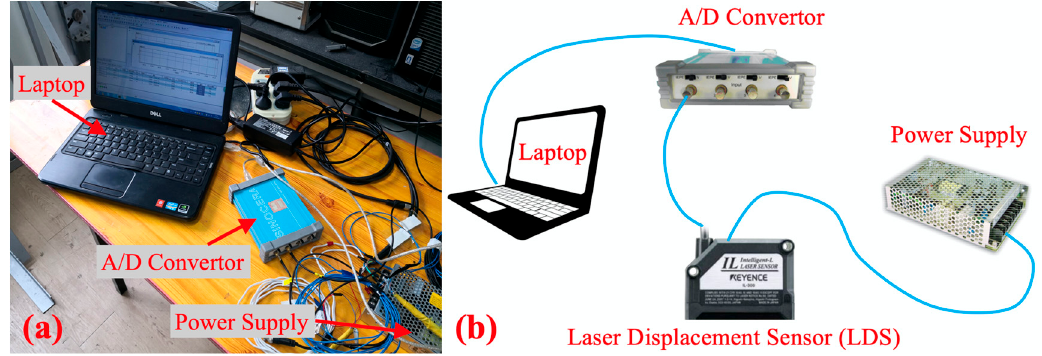
Figure 5. The layout of an LDS monitoring system: ( a ) Data collecting device; ( b ) Instrument connection.